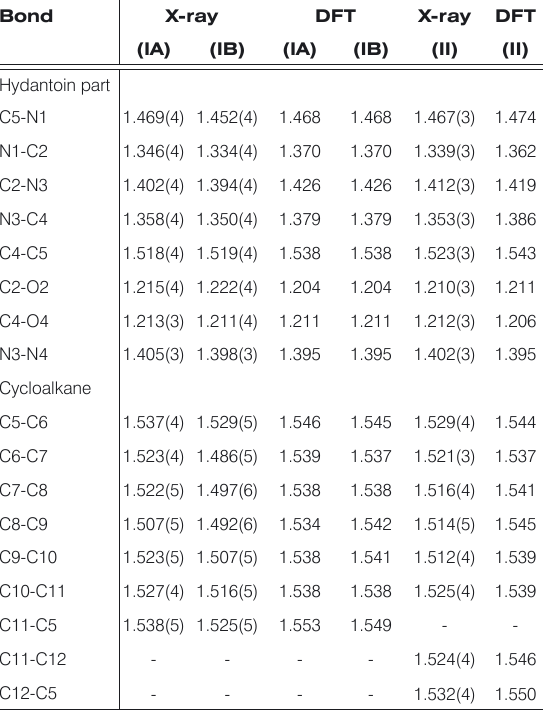
Table 2. Selected geometrical parameters for X-ray structures and DFT